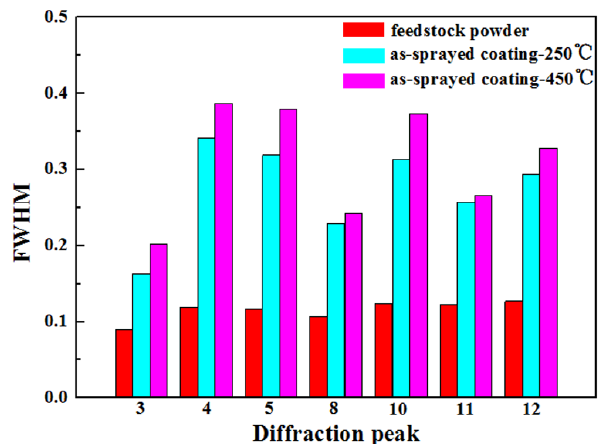
Figure 8. Full widths at half maximum (FWHMs) of the diffraction peaks of the feedstock powder and the as-sprayed coatings.